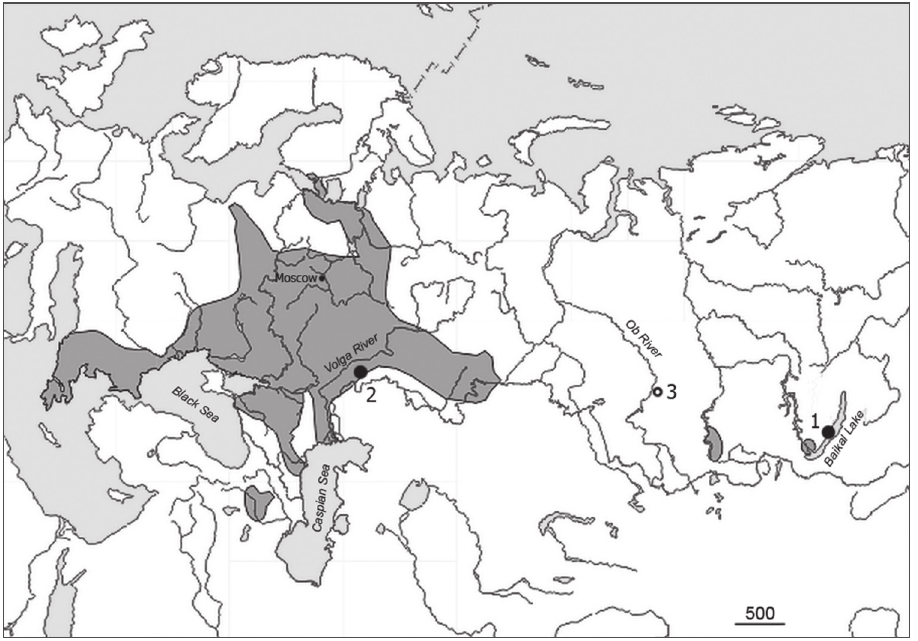
Figure 1. Map showing collection sites for the 54-chromosome (Sibling) vole under study. Black circles – our data ( 1 Olkhon isl., Lake Baikal 2 Dyakovka, left bank of Volga River.) Open circle – most recent Siberian finding 3 Novosibirsk vic., right bank of Ob River. Colored are the territories where verified find- ings (karyotype, allozymes) were obtained